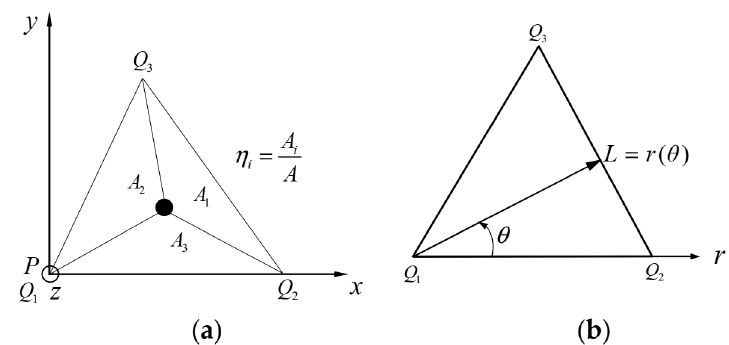
Figure 5. Local coordinate systems: ( a ) local oblique coordinate system; ( b ) local polar coordinate